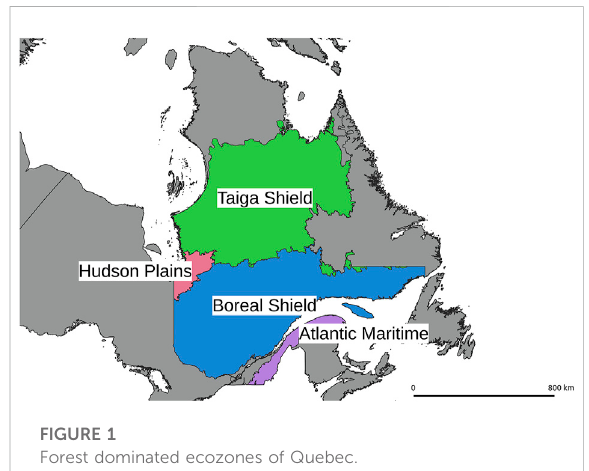
FIGURE 1 Forest dominated ecozones of